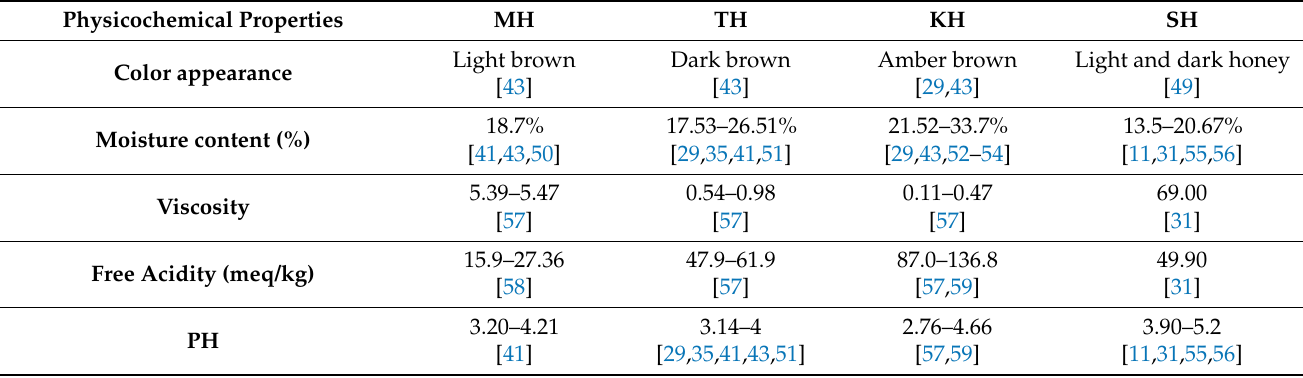
Table 1. The physicochemical characteristics of TH, KH, SH versus